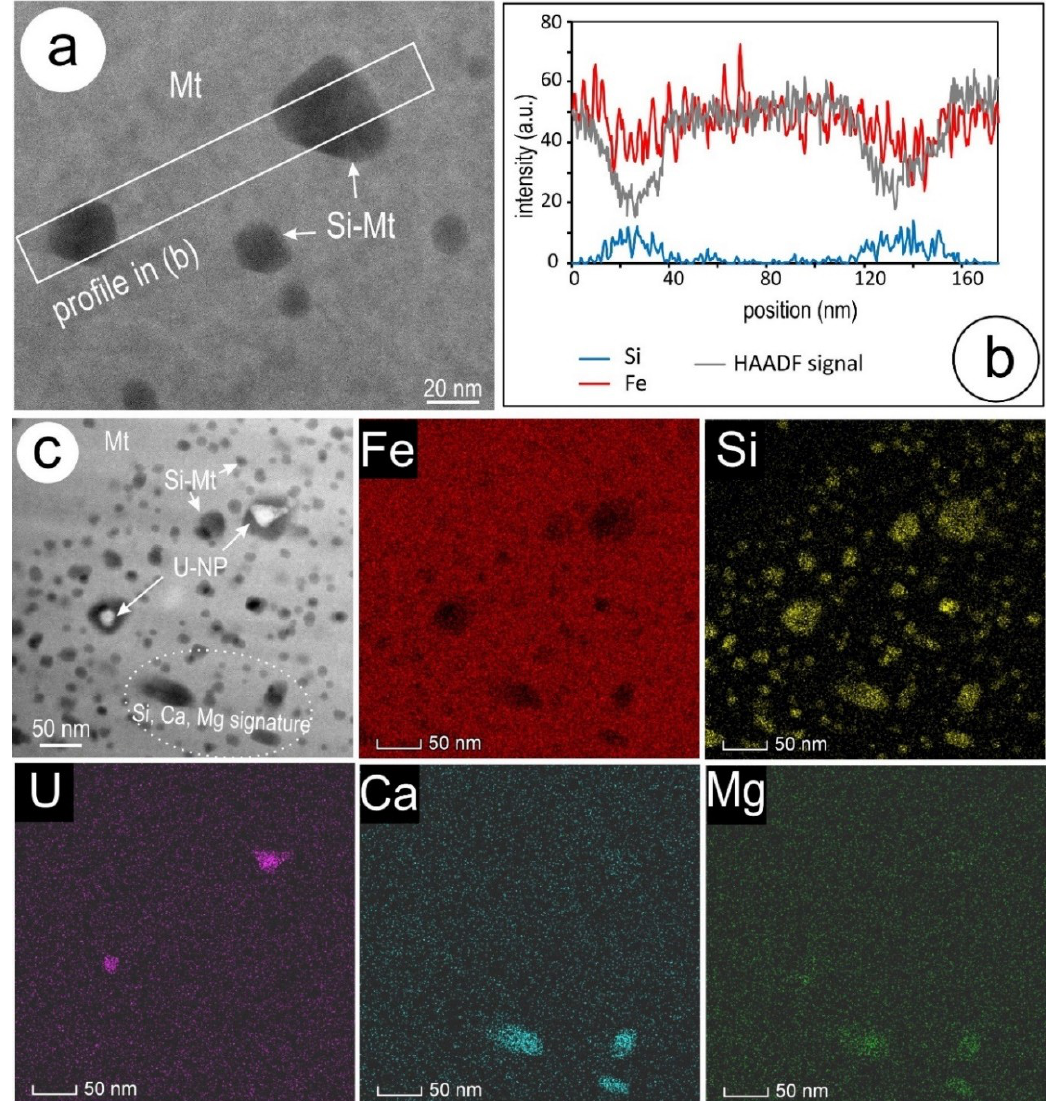
Figure 4. ( a ) HAADF STEM image and EDS-STEM profile ( b ) showing a field of Si-bearing nanoparticles (tens of nm; Si–Mt) in coarse magnetite (Mt) (foil #1, FIB cut shown in Figure 2a). ( c ) Image and EDS-STEM element maps showing a field with denser inclusions in the same foil. Note that the dominant inclusions are Si-bearing (Si–Mt), whereas a minority are either U-bearing NPs or Si–Ca–Mg bearing (bright and dark on HAADF STEM image, respectively). The latter define a Si–Ca–Mg signature part of the nanoprecipitates attributable to silician magnetite.